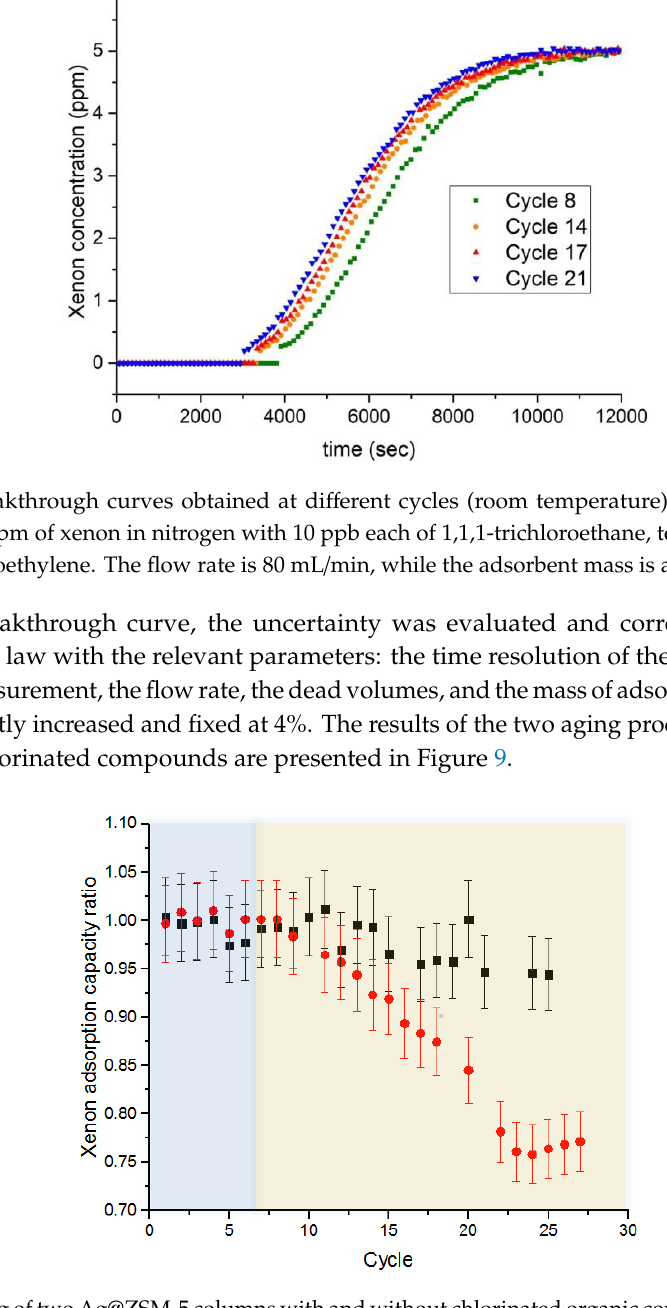
only during the xenon breakthrough—which means a contact time of 4 hours at 80 mL/min.